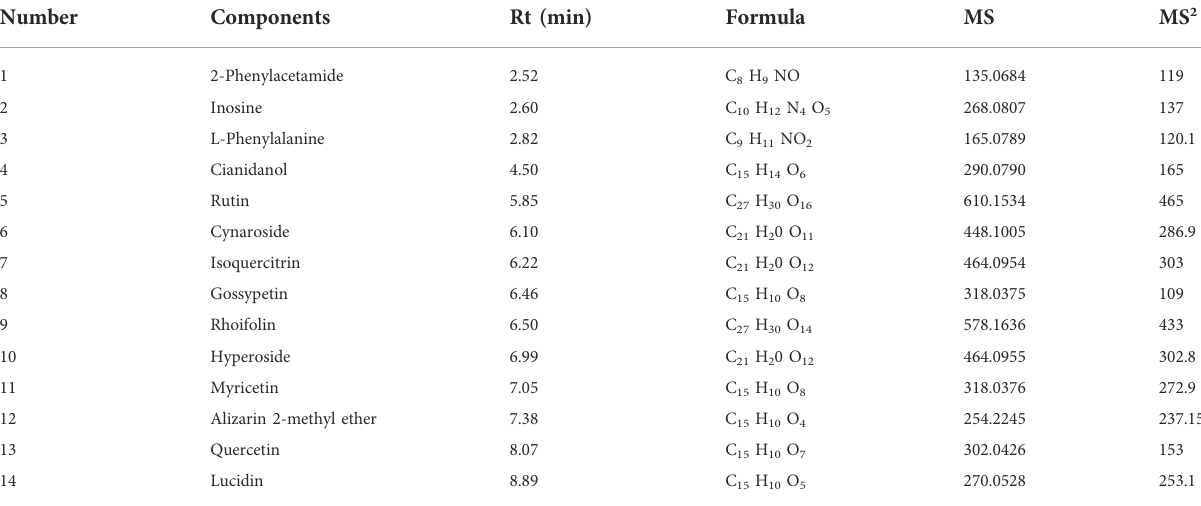
TABLE 3 HLD bioactive